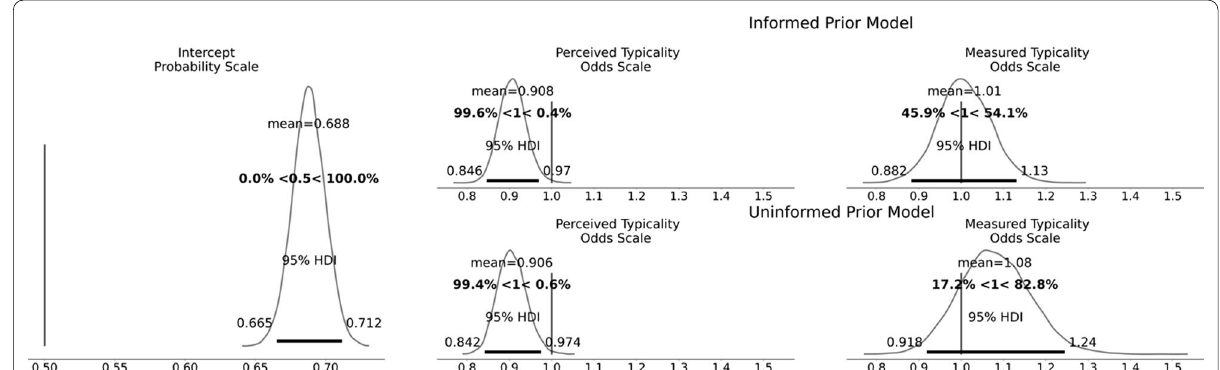
Fig. 5 Posterior distribution of coefficients when manipulating the upper face, from models with both informed and uninformed priors. Note the intercept posterior is identical in both models